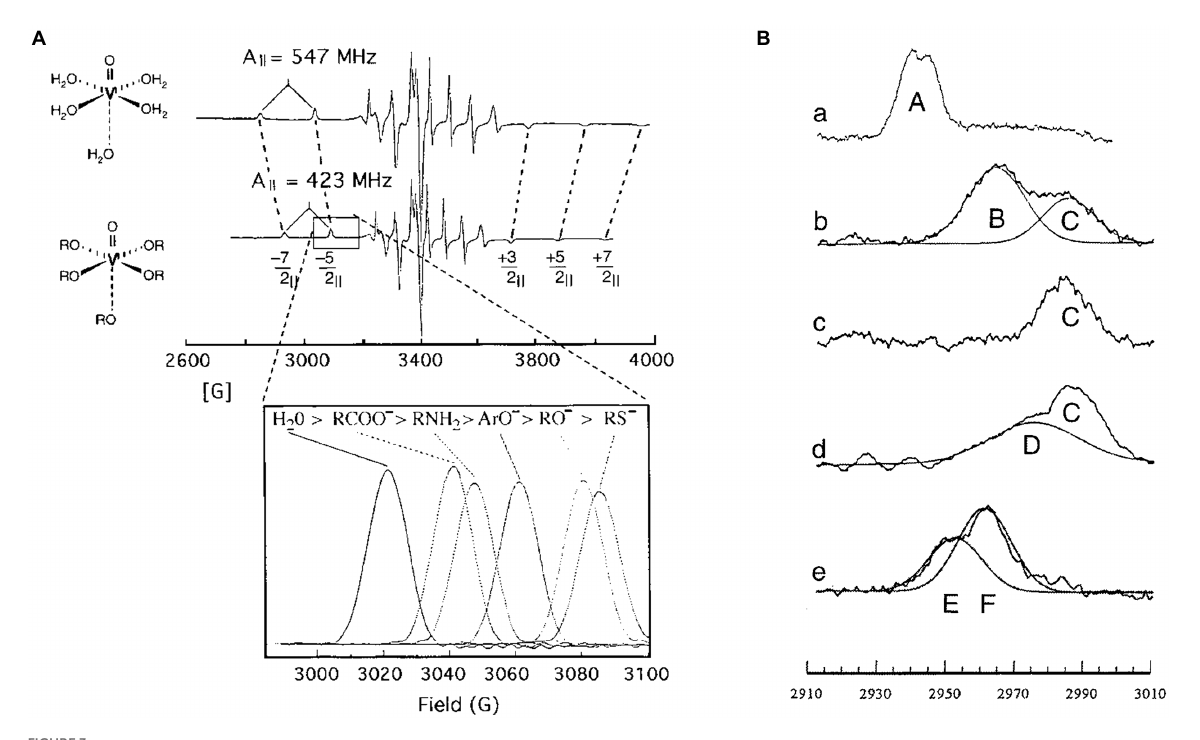
FIGURE 3 Sequential conformational changes of vanadyl-nucleotides bound to specific F 1 -ATPase catalytic sites demonstrate the F 1 binding-change mechanism. (A) Equatorial ligands determine 51 V-hyperfine Parameters of VO 2+ . EPR spectra of VO 2+ with water (top) or hydroxyl groups (bottom) as equatorial ligands. The parallel transitions ( − 7/2 || , − 5/2 || , +3/2 || , +5/2 || , and + 7/2 || ) that are not superimposed with perpendicular transitions are identified. Inset: dependence of the − 5/2 || transition on the type of equatorial ligands. (B) The − 5/2 || transition(s) of VO 2+ bound to So F 1 as: (a) VO 2+ –ATP at latent Site-2, (b) VO 2+ –ADP bound to latent Site-3, (c) VO 2+ –ADP bound to activated Site-3, (d) VO 2+ –ATP bound to activated site 3; and (e) VO 2+ –ATP bound to Site 1 using So F 1 – ε . This figure was modified from Frasch (2000a,b) with permission of the